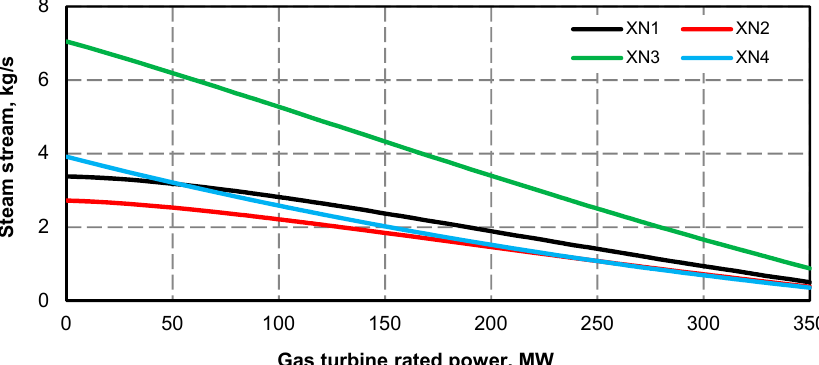
Figure 20. The streams of extraction steam for the XN1–XN4 low-pressure regeneration exchangers for a minimum steam boiler output of 133.3 kg/s and gas turbine operating at 60% of its rated power.